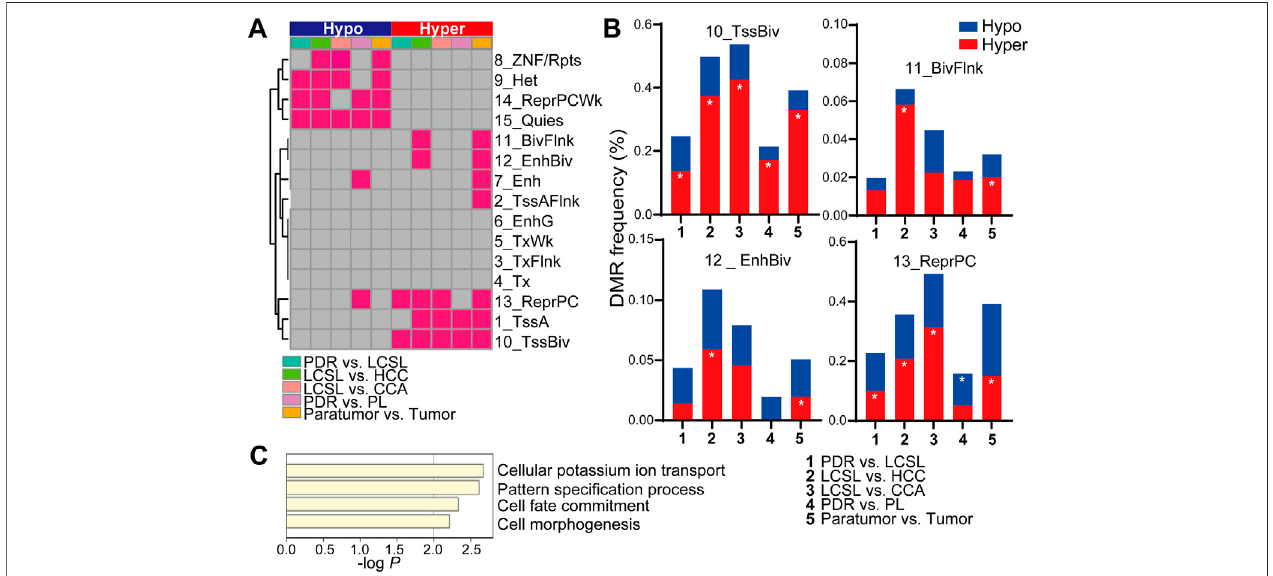
FIGURE 4 | DNA methylation changes in LCSL cells correspond to a chromatin restriction state. (A) Signi fi cant DMR distribution in different chromatin states. We used a 15-state model consisting of eight active states and seven repressed states, as suggested in reference (Roadmap Epigenomics et al., 2015). Each red square represents signi fi cant enrichments of hypermethylated or hypomethylated DMRs in the latter cell type (Q-value < 0.01). (B) DMR frequency between different cell types in different chromatin states. Both hypomethylation and hypermethylation DMR frequencies between the two indicated cell types in the chromatin states 10_TssBiv, 11_BivFlnk, 12_EnhBiv and 13_ReprPC are shown. DMR frequency = DMR tiles in the chromatin state/all common identi fi ed tiles between the two cell types × 100%. The symbol * represents signi fi cant DMR enrichment of hypomethylation or hypermethylation in the latter cell type, as shown in (A) . (C) The functions of genes corresponding to the hypermethylated DMRs between PDR and LCSL cells in the chromatin states 10_TssBiv and 13_ReprPC.